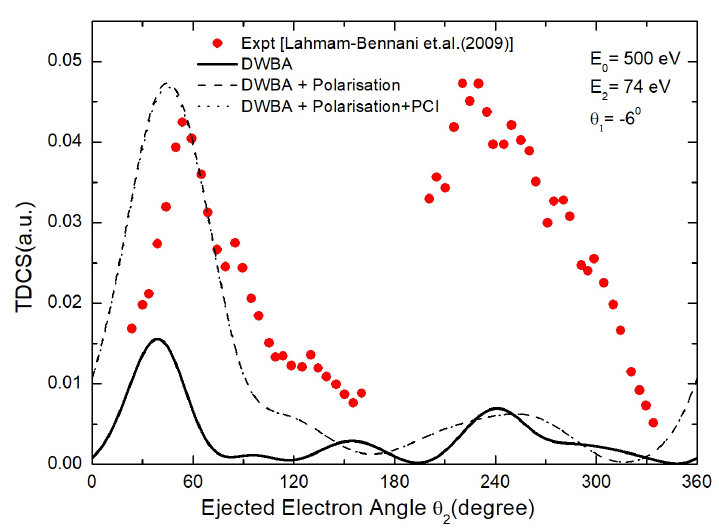
Figure 8. Kinematics is same as Figure 4 and the ejected electron energy chosen is 74